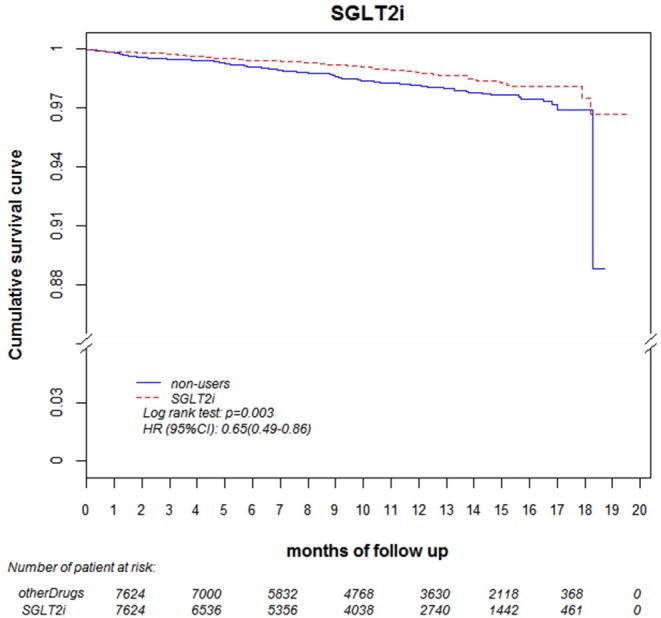
AKI-related hospitalization-free survival rates in patients with diabetes. Outcomes were estimated using Cox regression models stratified according to history of hospitalization related to AKI for SGLT2 inhibitor users vs. non-users. eGFR, estimated glomerular filtration rate; SGLT2i, sodium–glucose cotransporter 2 inhibitor; AKI, acute kidney injury.